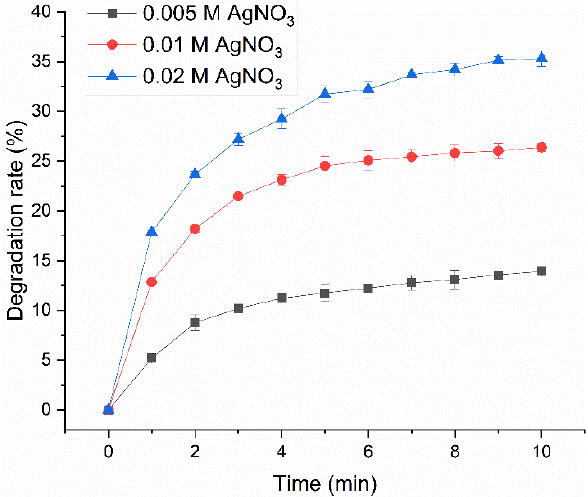
Figure 2. Degradation behavior of the HHK/PEO/PVA nanofibers treated with different concentra- tions of the silver nitrate solution. tions of the silver nitrate